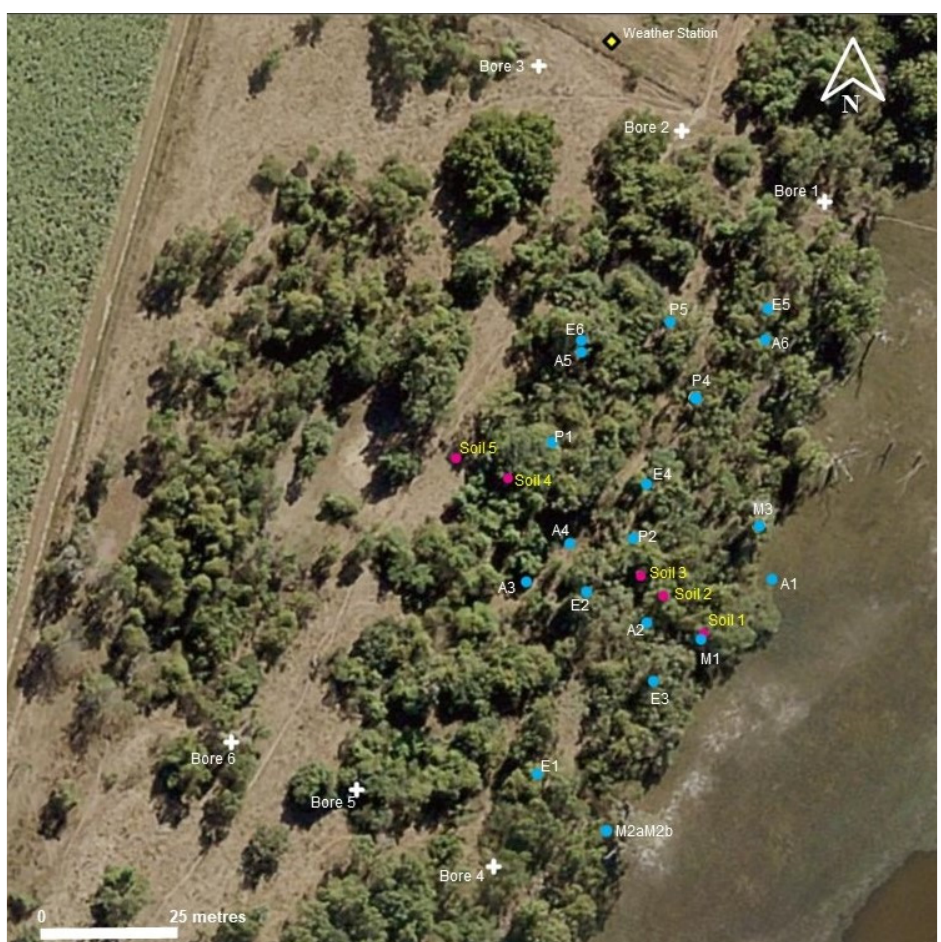
Figure 1. Site map showing locations of trees monitored, bores (labeled Bore1, Bore2, Bore3, Bore4, Bore5, Bore6), soil monitoring sites (labeled soil1, soil2, soil3, soil4, soil5) and the weather station, relative to the furrow irrigated sugarcane field on the west and the lagoon on the east. The individual tree IDs used for these species relate directly to the species name: Eucalyptus tessellaris (E1, E3, E4, E5 and E6), Melaleuca dealbata (M1, M2A, M2B and M3), Pandanus cookii (P1, P4 and P5), and Acacia salicina (A1, A2, A3, A4, A5 and